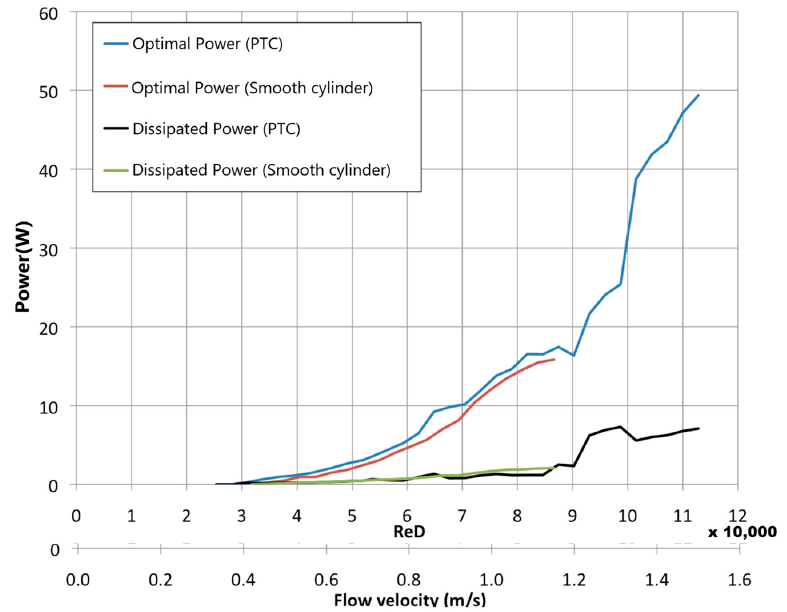
Figure 5. Optimal harnessed power envelope of VIVACE converter with and without PTC [14].